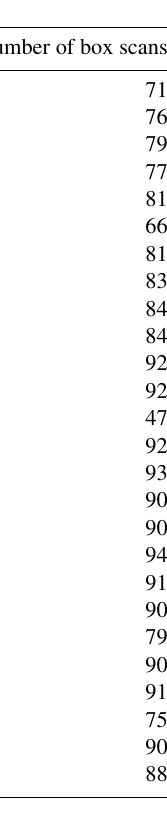
Table A1. Overview of the solar box scan database used in this work. In total 2157 solar box scans are used in the analysis, which were acquired by the Hohenpeißenberg (MHP)